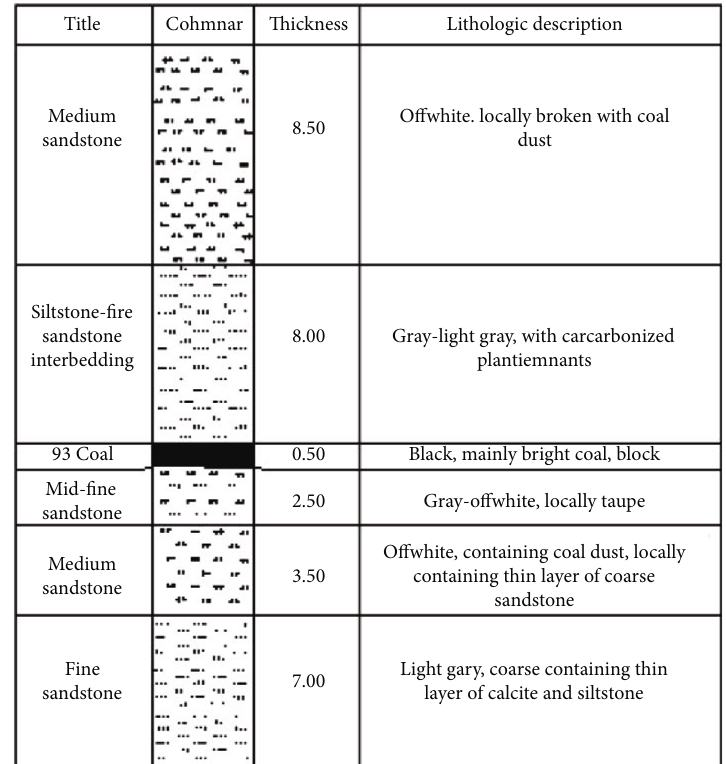
Figure 7: Histogram of coal strata.